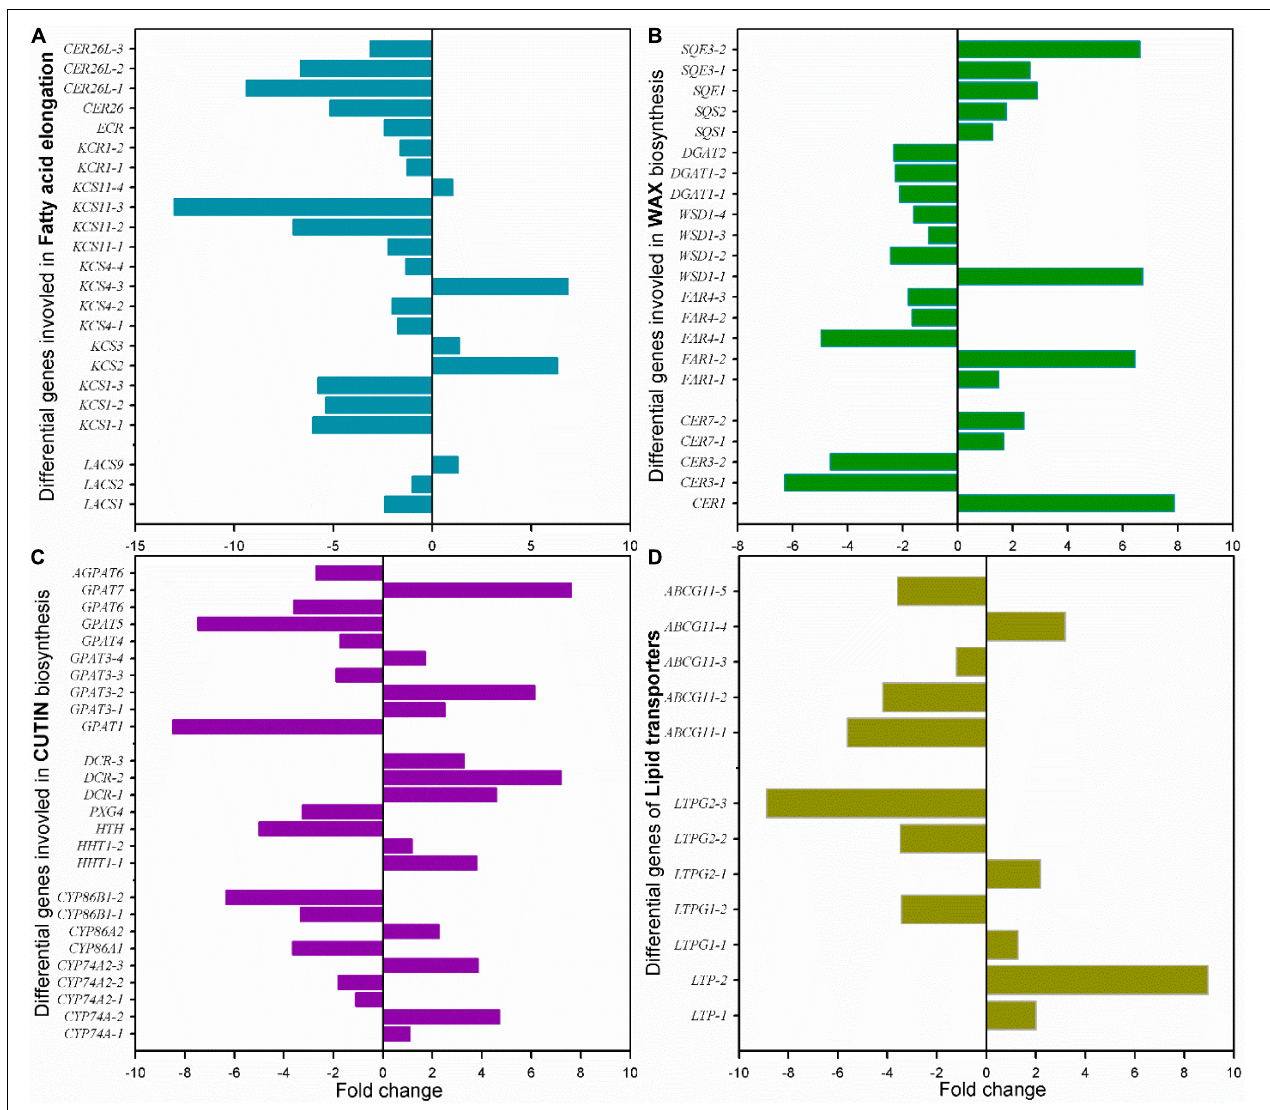
FIGURE 8 | Changes of the main differential genes in cuticle biosynthesis of banana fruit during storage. (A) 23 DEGs in fatty acid elongation pathway, (B) 22 main DEGs in wax accumulation pathway, (C) 26 main DEGs in cutin monomer biosynthesis pathway, and (D) 12 DEGs for lipid-transfer proteins involved in cuticle forming were